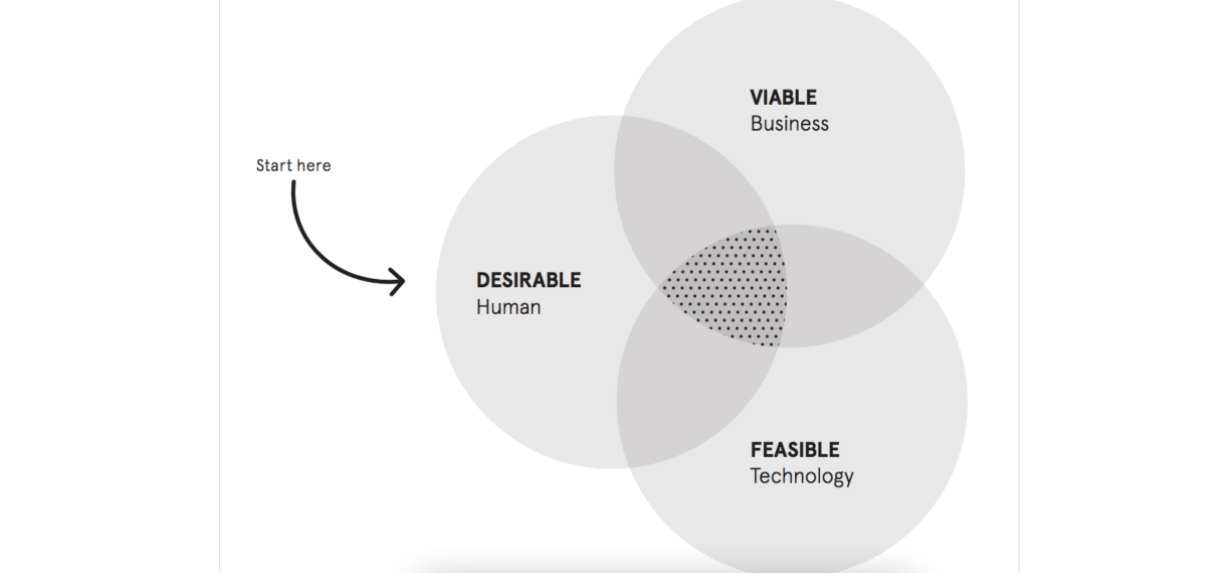
Figure 2. Human Centered Design model from